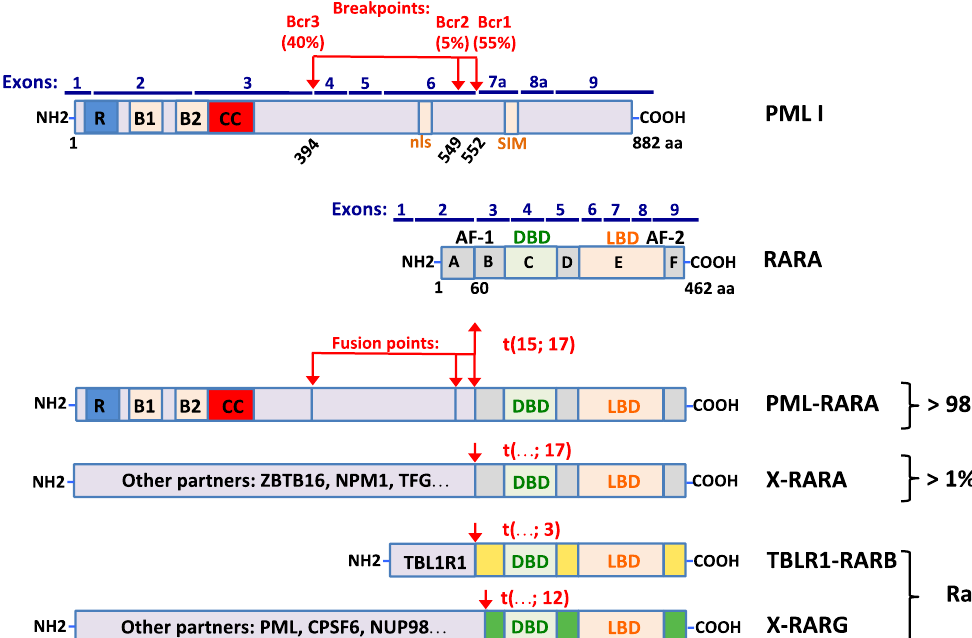
Figure 1. Structural organization of PML-RARA and other PML-independent RAR fusions in acute promyelocytic leukemia (APL) cells. Schematic representations of PML (isoform I), RARA and fusion partners of other retinoic acid receptors (RARB and RARG) before and after chromosomal rearrangements. Exons are shown in blue. The frequency of breakpoint cluster regions (Bcr) in APL is indicated in a percentage and fusion points are represented by a red arrow. The RING finger (R), B-boxes (B1 and B2), coiled-coil domain (CC), nuclear signal (nls) and sumo-interactif motif (SIM) in PML are represented by different colored boxes as well as functional domains in RARA: A-B: AF-1 transcriptional domain; C: DNA binding domain (DBD); D: hinge region; E: ligand binding domain (LBD), heterodimerization and AF-2 transactivation domain; F: unknown function.